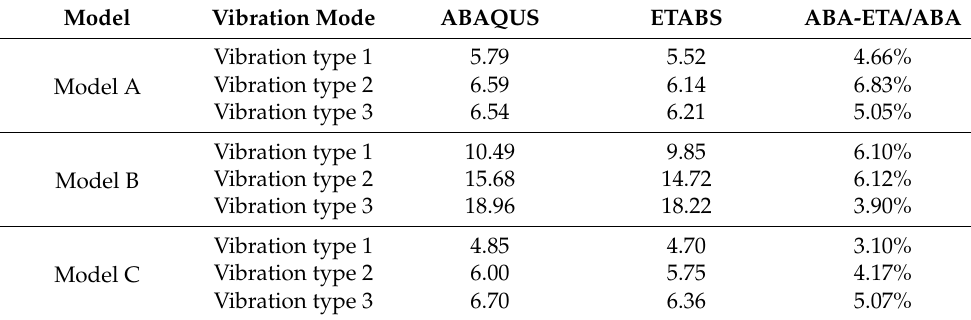
Table 1. A comparison of the natural frequency of the models.